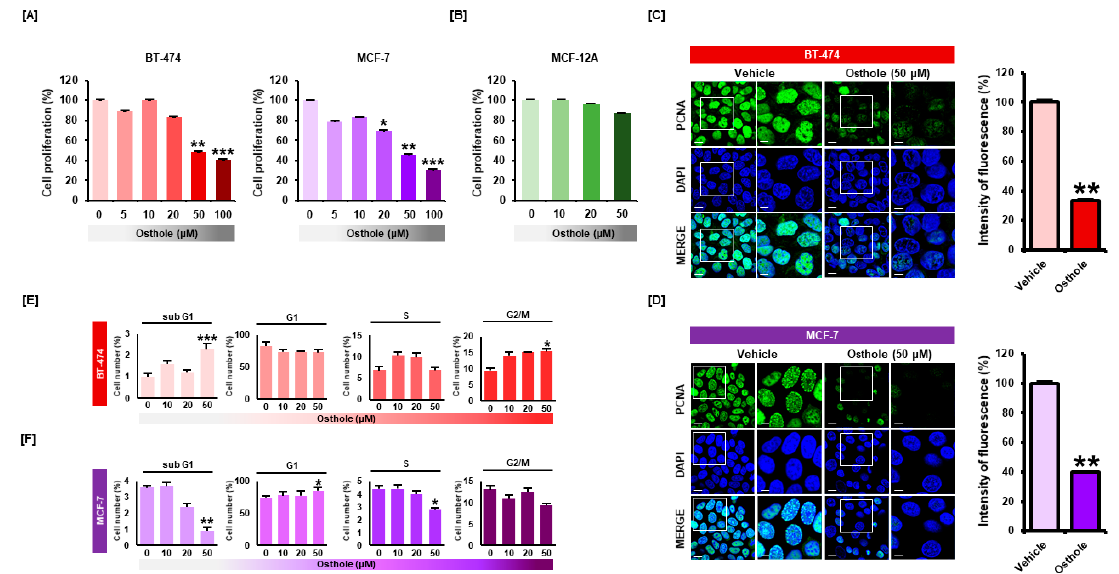
Figure 1. Osthole inhibited cell proliferation in human breast cancer cells. ( A ) Proliferation of breast cancer cells was analyzed using cell proliferation assays. Osthole (0, 5, 10, 20, 50, and 100 μ M) decreased the proliferation of BT-474 and MCF-7 cells in a dose-dependent manner. ( B ) Effect of osthole on MCF-12A normal mammary epithelial cell proliferation in a dose dependent manner (0, 10, 20, and 50 μ M). ( C , D ) Proliferative cell nuclear antigen (PCNA) was detected using immunofluorescence analysis. The green signal associated with PCNA was attenuated in osthole-treated cells compared to vehicle-treated cells. Nuclei were counterstained with DAPI (blue). The graph shows the intensity of PCNA fluorescence. ( E , F ) Regulatory effect of osthole on cell cycle progression in breast cancer cells. The number of cells in each cell cycle phase was analyzed by propidium iodide (PI) staining of DNA contents using flow cytometry. All experiments were performed in biological triplicate and the asterisks represent statistically significant differences compared to control (DMSO-treated cells; 0 μ M) (* p < 0.05, ** p < 0.01 and *** p < 0.001).